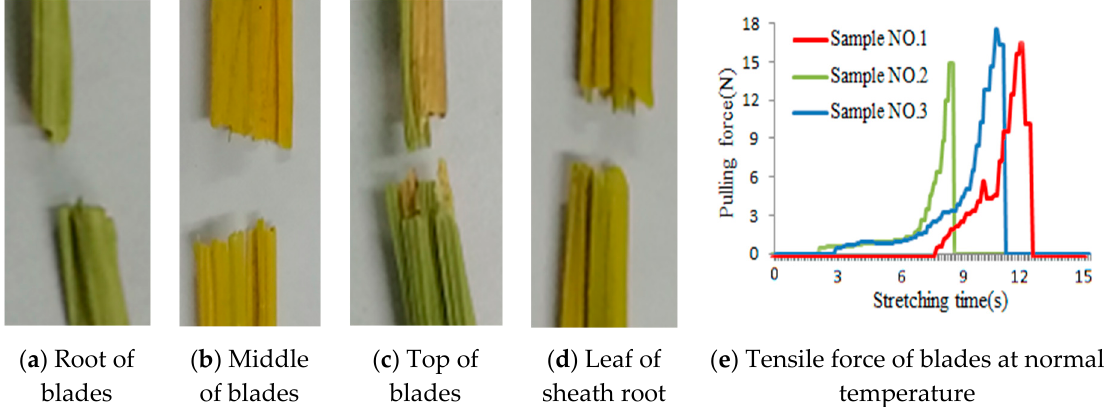
Figure 11. Tensile fracture states and tensile force curve of three-point stretching blades.